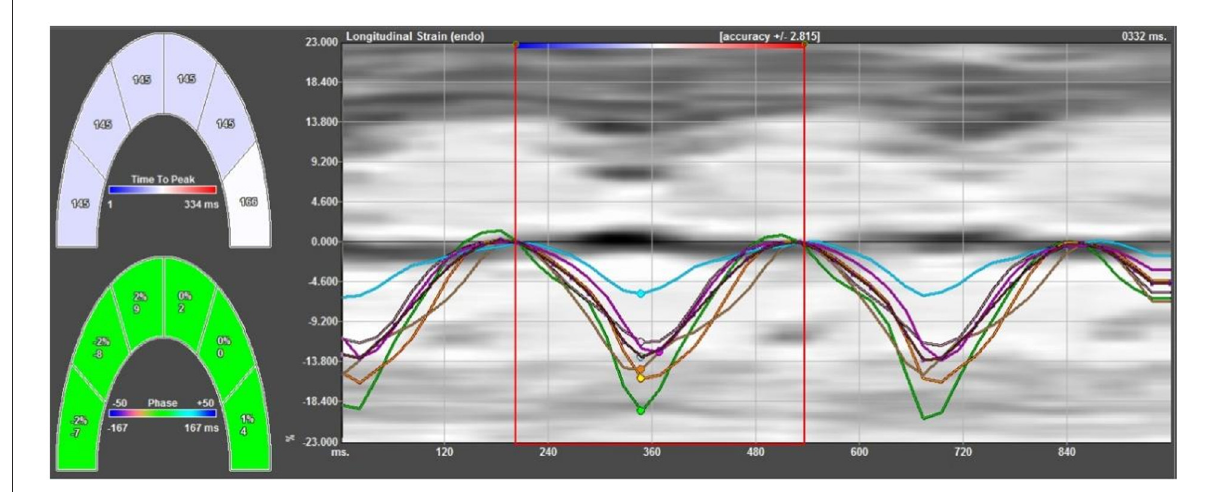
FIGURE1 Strain curves of all segments of the left ventricular lateral wall and left ventricular side of the ventricular septum. The strain curve has a negative single peak in the whole cardiac cycle; in the systolic phase, the myocardium shortens longitudinally, developing from zero to negative, and reaches its maximum strain at the end of the systolic phase, gradually returning to zero in the diastolic phase.